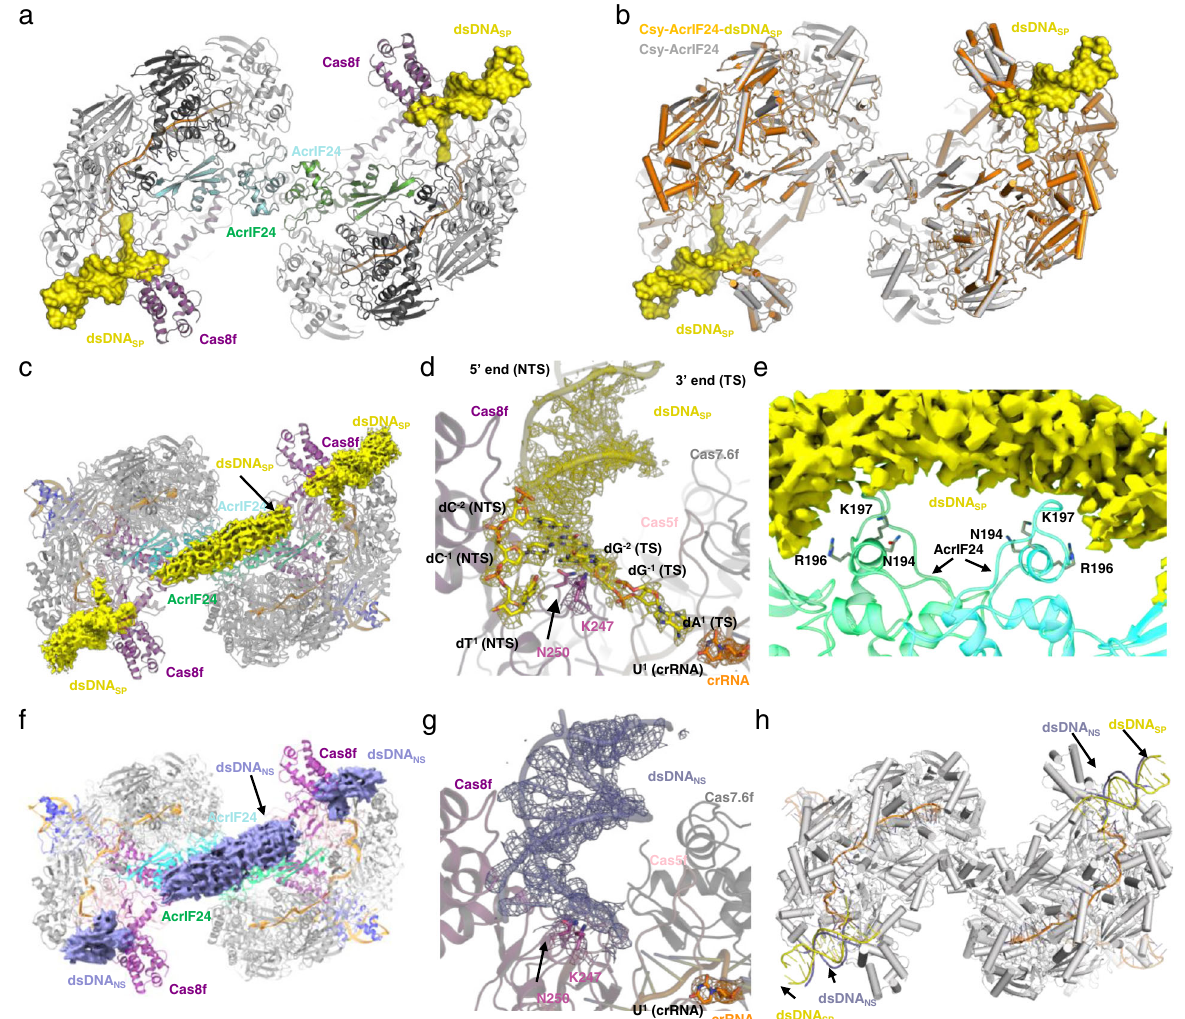
Fig. 6 Cryo-EM structure of Csy-AcrIF24-dsDNA complexes. a Atomic structure of Csy-AcrIF24-dsDNA SP in cartoon representation with each subunit colored as in Fig. 3d. The bound dsDNA SP molecules are shown in surface model colored in yellow. b Structural superimposition between Csy-AcrIF24- dsDNA SP and Csy-AcrIF24. The structures of Csy-AcrIF24-dsDNA SP and Csy-AcrIF24 are colored in orange and gray, respectively. The dsDNA SP is shown in the surface model colored in yellow. c The densities corresponding to dsDNA molecules in the Csy-AcrIF24-dsDNA SP structure are shown in yellow mesh. The Csy and AcrIF24 are colored as in Fig. 3d. d Close-up view of the binding site of dsDNA SP near the PAM recognition loop in Cas8f in the Csy- AcrIF24-dsDNA SP complex. The cryo-EM density maps for dsDNA SP , K247 of Cas8f and U1 of the crRNA are shown in mesh. e Close-up view of the interfaces between AcrIF24 and the dsDNA SP density within the Csy-AcrIF24-dsDNA SP complex. The density corresponding to dsDNA is shown as yellow mesh and N194/R196/K197 is shown in sticks. f The densities corresponding to dsDNA molecules in the Csy-AcrIF24-dsDNA NS structure are shown in the slate mesh. The Csy and AcrIF24 are colored as in Fig. 3d. g Close-up view of the binding site of dsDNA NS near the PAM recognition loop in Cas8f in the Csy-AcrIF24-dsDNA NS complex. The cryo-EM density maps for dsDNA NS , K247, and N250 of Cas8f and U1 of the crRNA are shown in the mesh. The base groups of dsDNA NS are shown in cartoon, although the sequence of dsDNA NS cannot be determined. h Structural superimposition between Csy-AcrIF24- dsDNA SP and Csy-AcrIF24-dsDNA NS . Only dsDNA NS (colored slate) molecules are shown in Csy-AcrIF24-dsDNA NS structure. The dsDNA SP is colored in